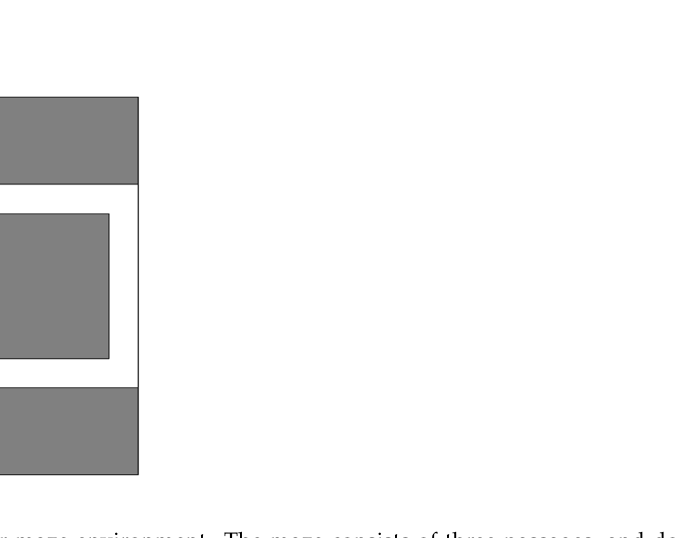
Figure 5. Tolman detour maze environment. The maze consists of three passages, and doors A and B are set in the passage to provide the dynamic environment. The size of the maze is set to 130 cm × 130 cm, and the coordinates of the start and goal are (35, 5) and (35, 125), respectively. Inputs of the hippocampal and striatal models are positions of the agent. The agent can obtain current location information by sensing the surroundings, which belongs to the research category of robot localization and will not be elaborated on specifically